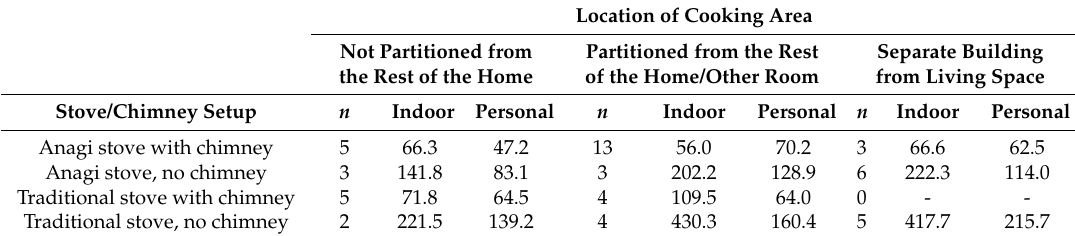
Table 2. Median * PM 2.5 concentrations ( µ g/m 3 ) for indoor and personal exposures for all households by kitchen location and stove/chimney setup.